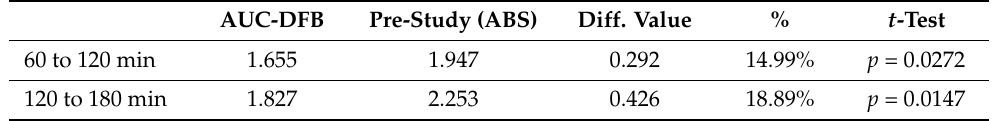
Table 8. RMSE comparisons between the ABS model and the AUC-DFB model using only the predictions that fall into the time range shown, i.e., predictions between 60 and 120 for the 120 min prediction and predictions between 120 and 180 for the 180 min. All values are in mmol/L.